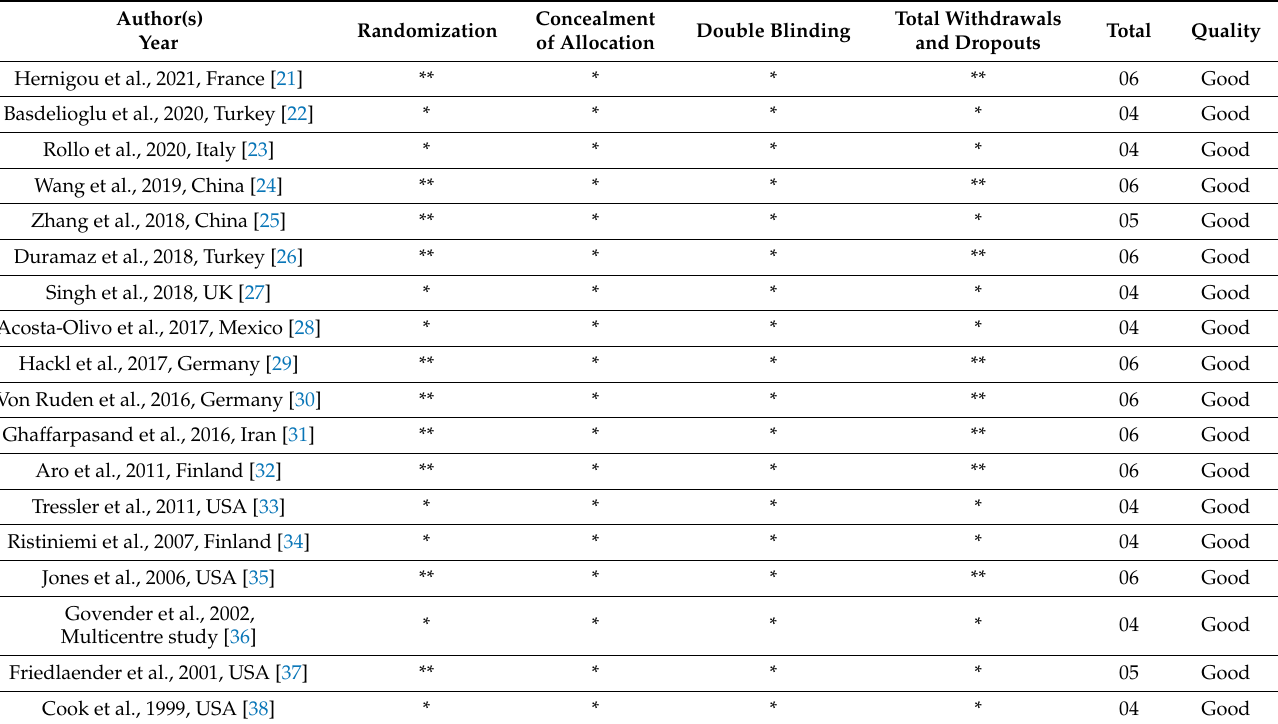
Table 4. Study quality of the included studies based on the modified Jadad scale (*: indicates one point, **: indicated two points).